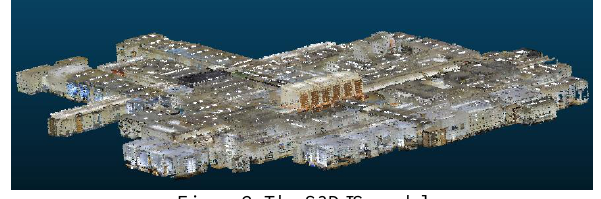
Figure 2. The S3DIS